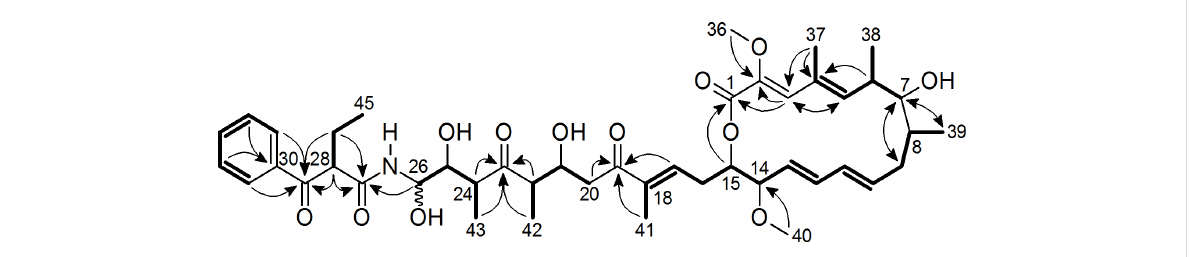
Figure 2: Structure fragments of lanyamycin ( 1 / 2 ) from 1 H, 1 H-COSY spectrum (bold bonds) and selected 1 H, 13 C-HMBC NMR correlations (arrows).